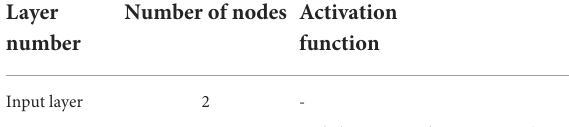
TABLE 2 Best ANN hyperparameters identified for the provided dataset.